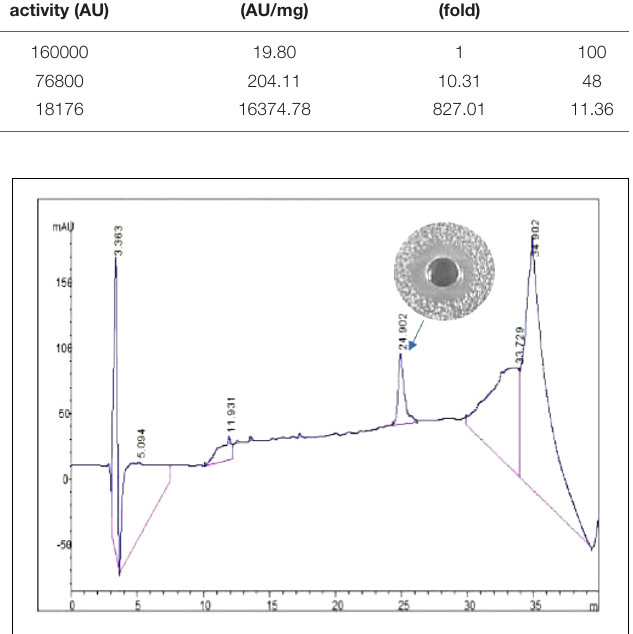
FIGURE 3 | Purification of bacteriocin Lac-B23 using SP Sepharose Fast Flow column. FIGURE 4 | Analytical HPLC chromatography of bacteriocin Lac-B23.